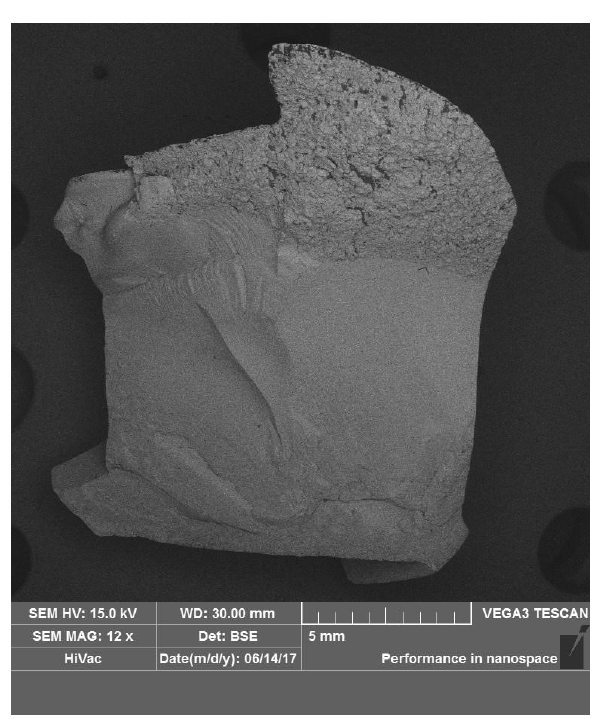
Figure 2: Surface appearance of the fractured end mill each other. V and Cr are also strong carbide former and re- fine the primary grain. Cobalt is not carbides former. It in- hibits grain growth at elevated temperatures and improves substantially retention of hardness and high temperature strength [18]. The carbides are very hard and significantly contribute to wear resistance and hot hardness